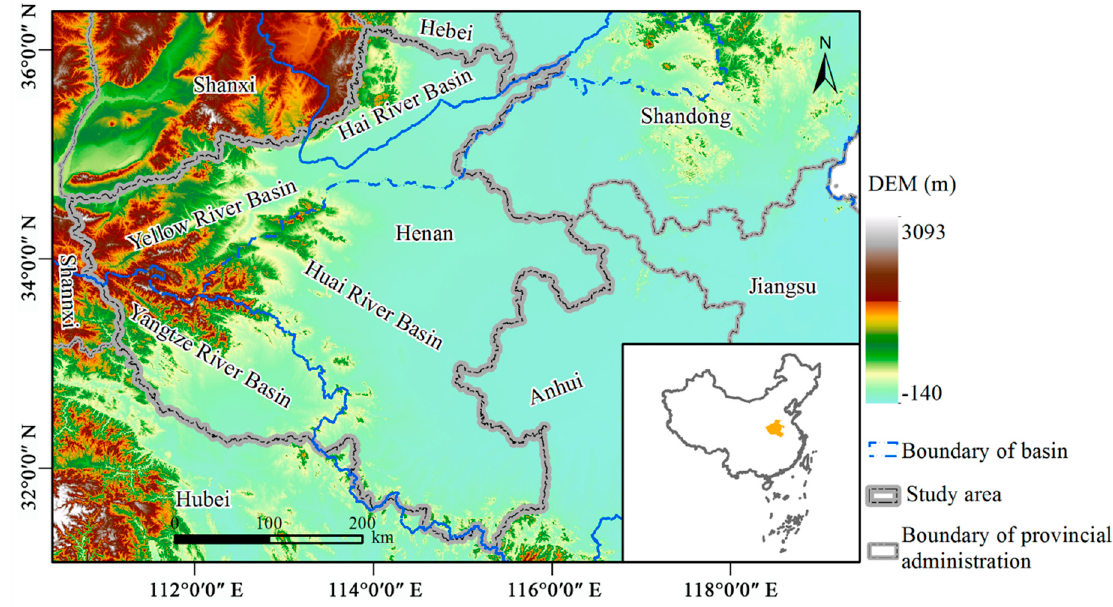
Figure 1. Geographical location of Henan Province in China.